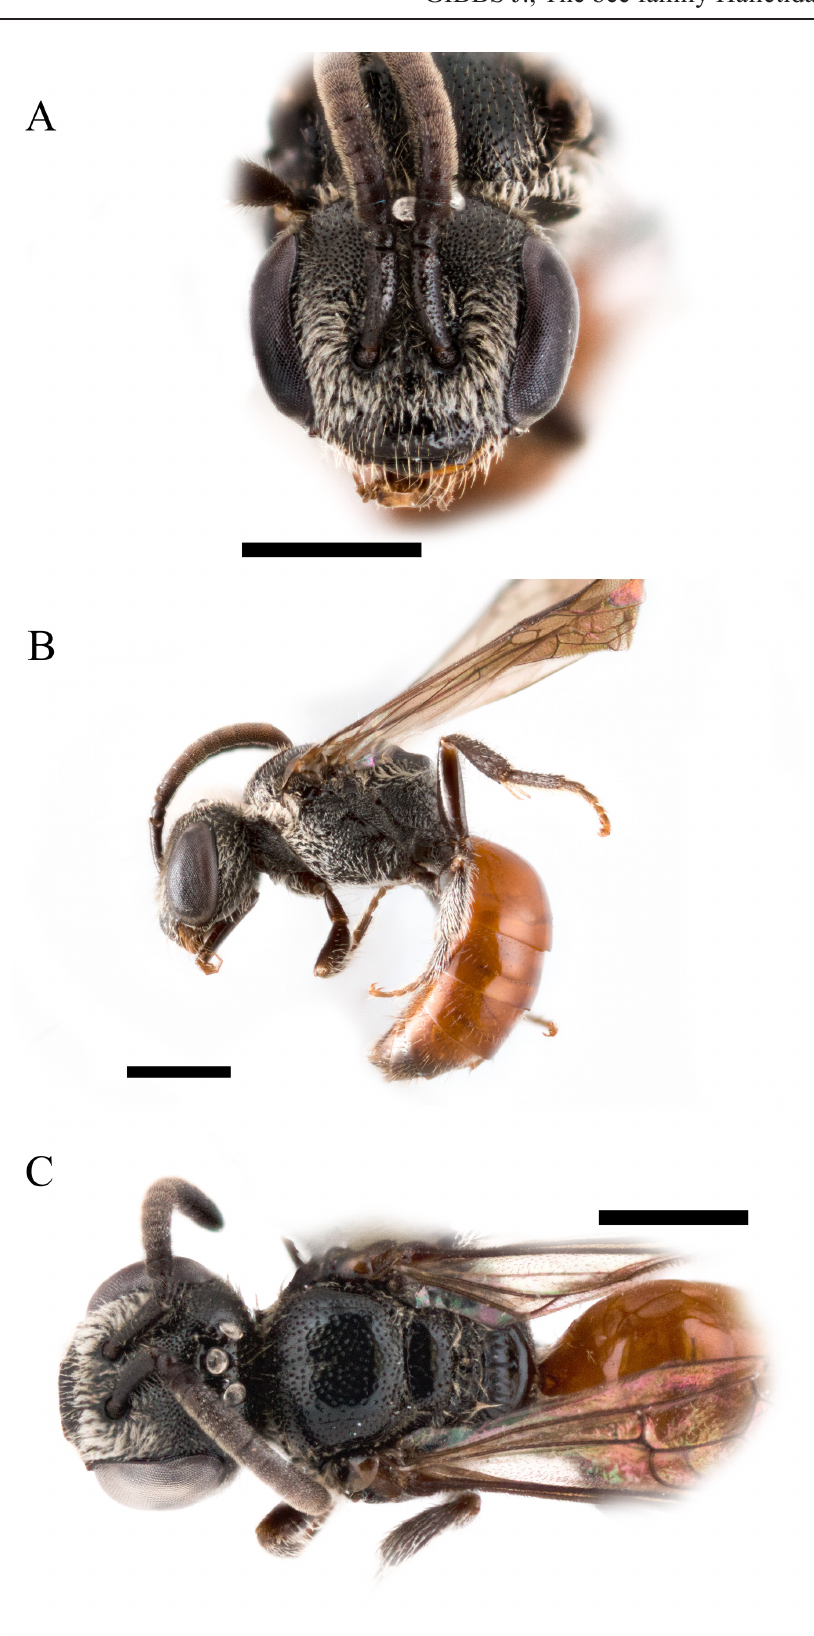
Fig. 10. Sphecodes diablotinus sp. nov. Paratypes, ♀♀. A . Face. B . Lateral habitus. C . Dorsum of mesosoma. Scale bars = 1